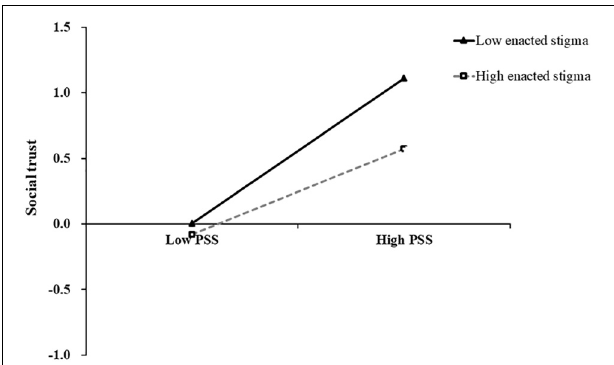
FIGURE 2 | The moderating effect of enacted stigma on the relationship between PSS and social trust.